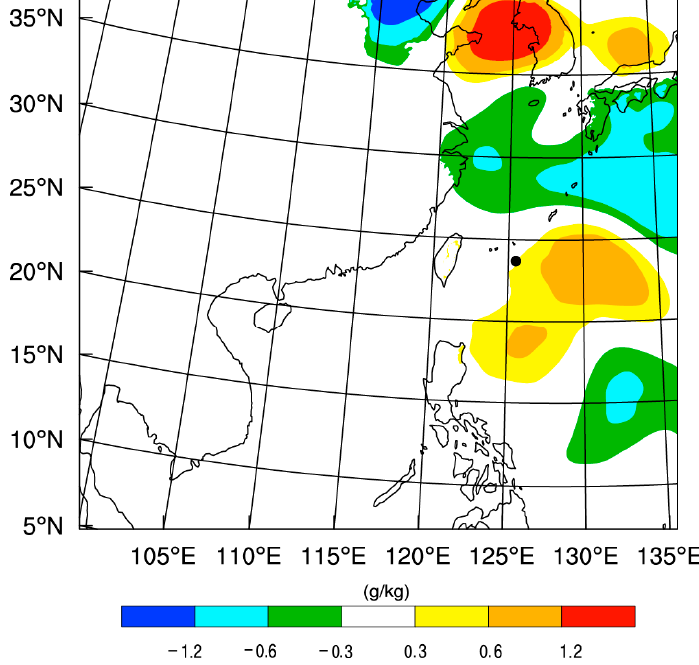
Figure 9. The 850 hPa water vapor increment (units: g/kg) between the analysis and the background at 0600 UTC 8 August 2019.